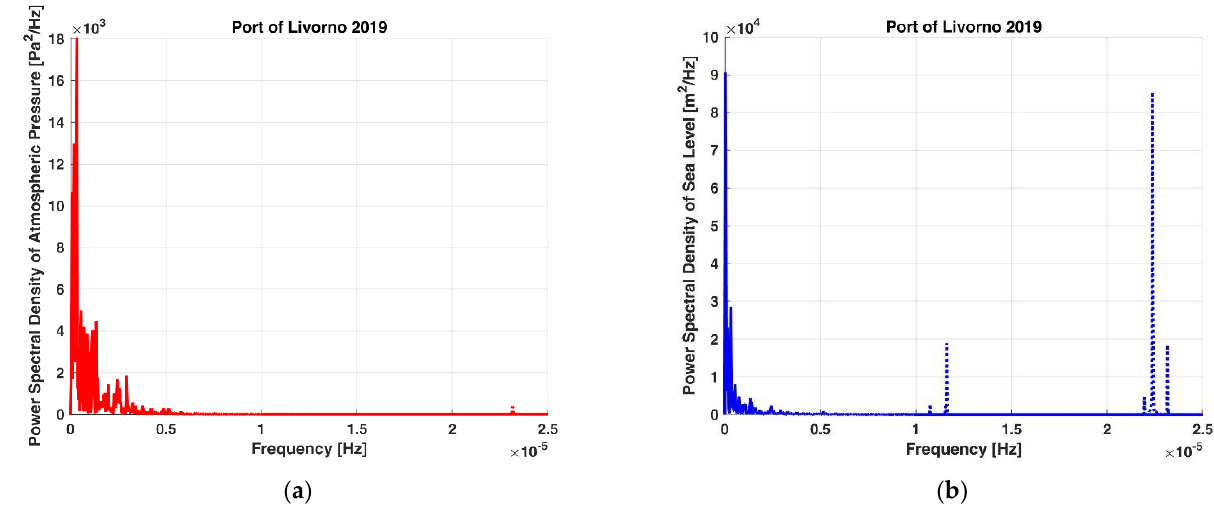
Figure 10. Power spectral densities of meteomareographic parameters acquired by ISPRA’s monitoring station in the port of Livorno in 2019: ( a ) atmospheric pressure; ( b ) sea level; solid lines: lowfrequency components surviving the filtering; dashed lines: highfrequency components eliminated by the filtering.